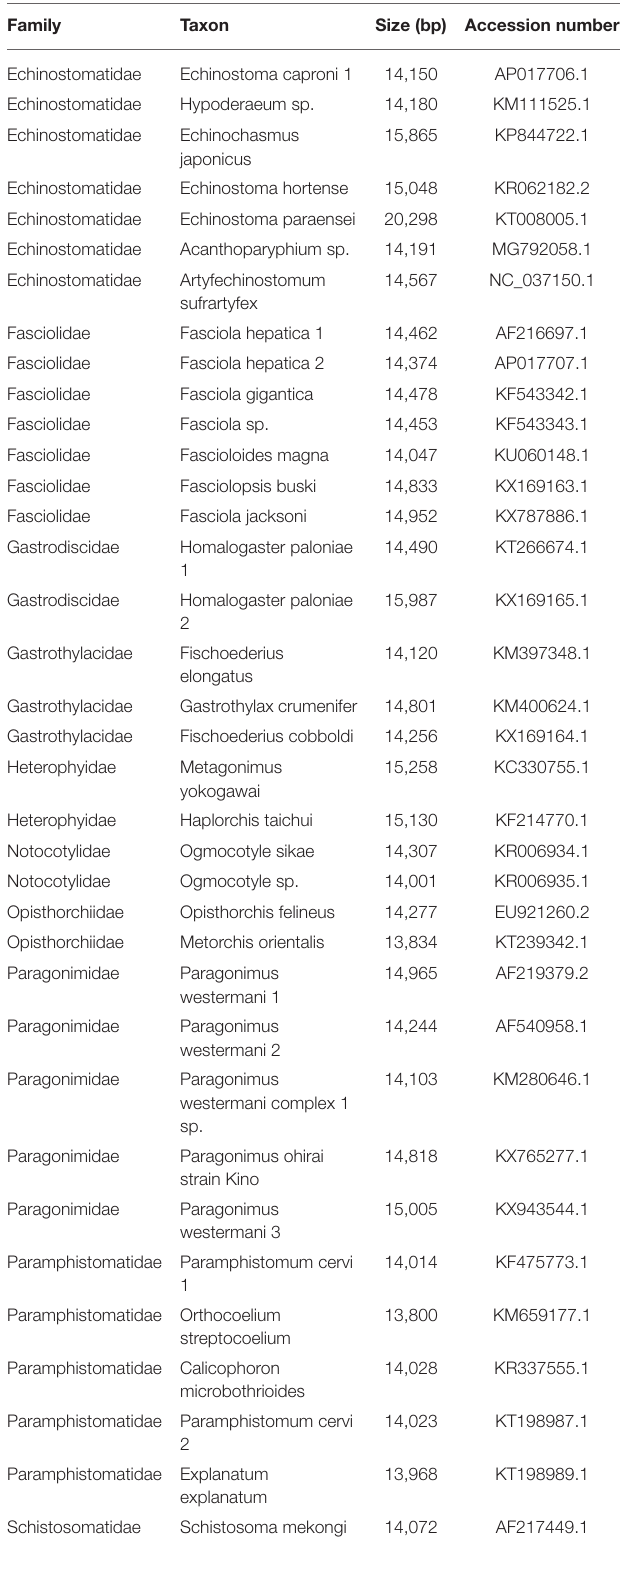
TABLE 2 | Mitochondrial genome sequences of F. intermediate